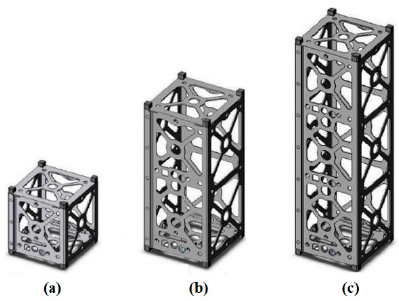
Figure 1. Cube Satellite: ( a ) 1U; ( b ) 2U; ( c ) 3U [11].